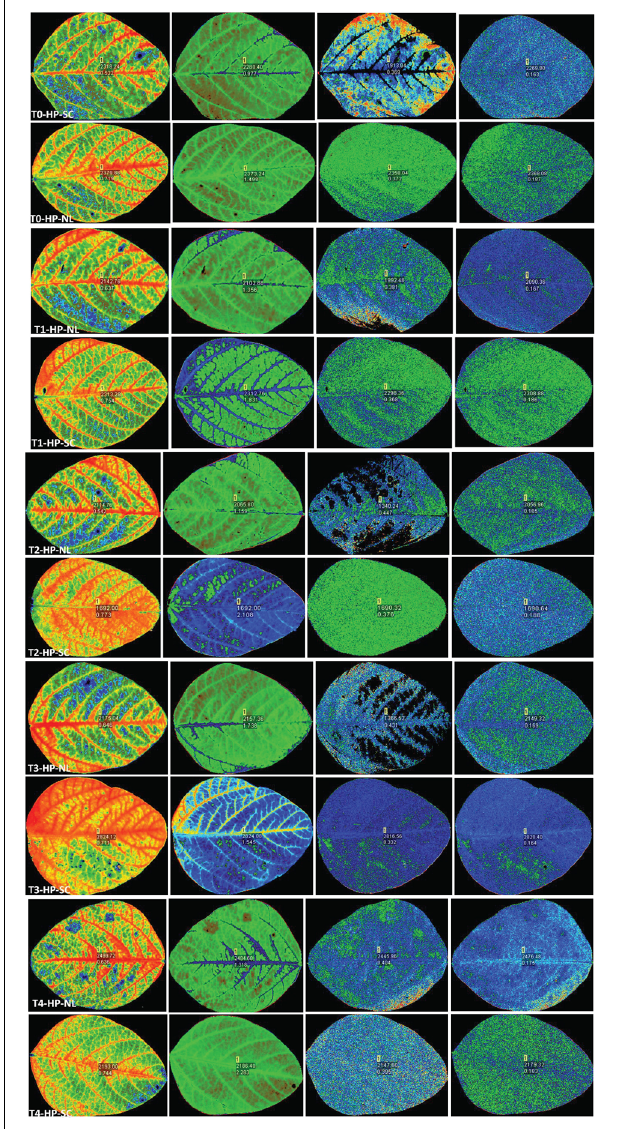
FIGURE 4 | Leaf chlorophyll fluorescence of soybean in response to Ti application under NL and SC combined with LP conditions. FIGURE 5 | Leaf chlorophyll fluorescence of soybean in response to Ti application under NL and SC combined with HP.